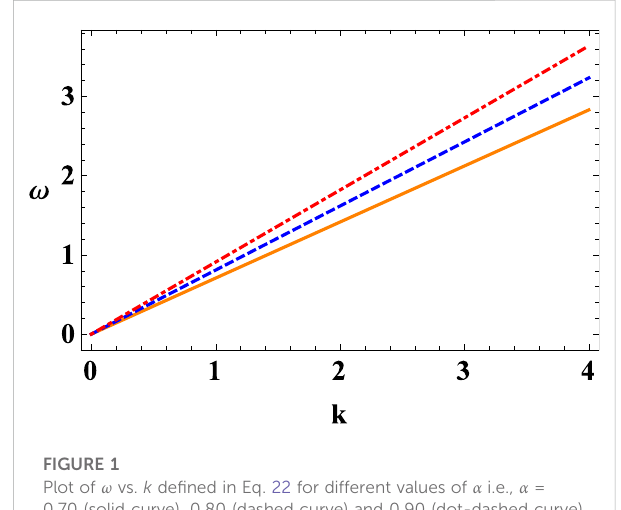
FIGURE 1 Plot of ω vs. k de fi ned in Eq. 22 for different values of α i.e., α = 0.70 (solid curve), 0.80 (dashed curve) and 0.90 (dot-dashed curve) with p (cid:3) = 0.2, γ = 0.2 and σ =